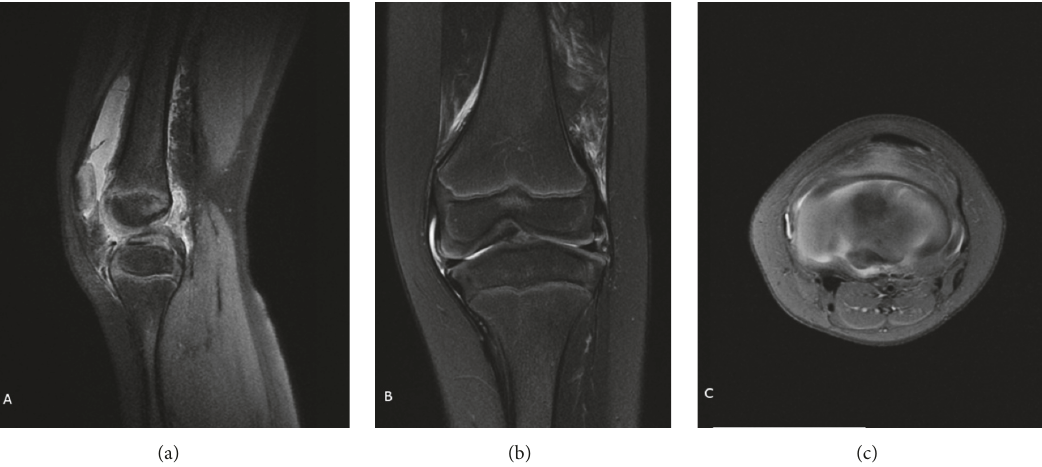
Figure 2: Preoperative MRI of the left knee of the patient from Figure 1 (sagittal (a), coronal (b), and transverse (c) views). Complete agenesis of the ACL and PCL hypoplasia is noted. The femoral intercondylar notch is completely covered by cartilage. The tibial spine is hypoplastic.